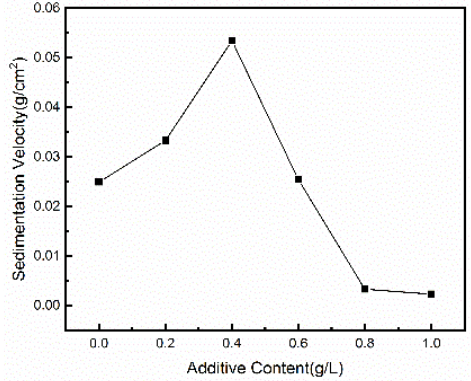
Figure 3. Peeling rate of as-prepared Mg(OH) 2 .